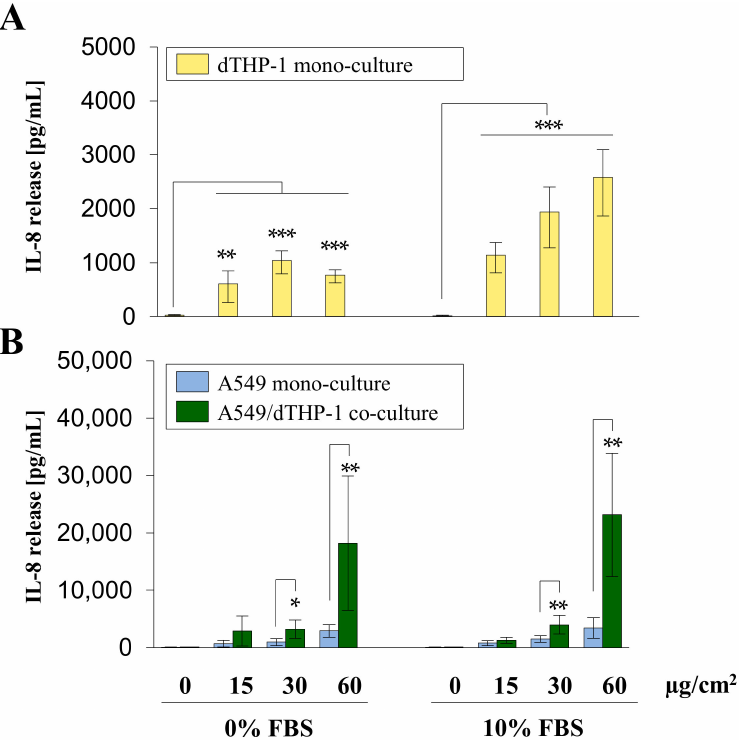
Figure 5. Interleukin-8 (IL-8) release from A549 and dTHP-1 mono-cultures as well as A549/dTHP- 1 co-cultures after submerged exposure to Min-U-Sil5. A549 and dTHP-1 cells were seeded as monocultures at a density of 2 × 10 5 /cm 2 and 2.95 × 10 4 /cm 2 , respectively ( A , B ). A549 cells were seeded with a density of 2 × 10 5 /cm 2 . After 4 h dTHP-1 cells (2.95 × 10 4 /cm 2 ) were seeded on top of the A549 cells for co-culture treatment ( B ). The next day, mono- and co-cultures were treated with 45, 90, or 180 µ g/mL (15, 30, or 60 µ g/cm 2 ) Min-U-Sil5 either in the presence or absence of FBS for 24 h. The supernatants were analyzed for IL-8 release. The means ± SD of three independent experiments performed in duplicates are displayed. Statistical analysis was performed to assess differences between untreated and treated cells (dTHP-1) and differences between mono- and co-cultures (A549, A549/dTHP-1) using student’s t -test: * ( p ≤ 0.05), ** ( p ≤ 0.01), *** ( p ≤